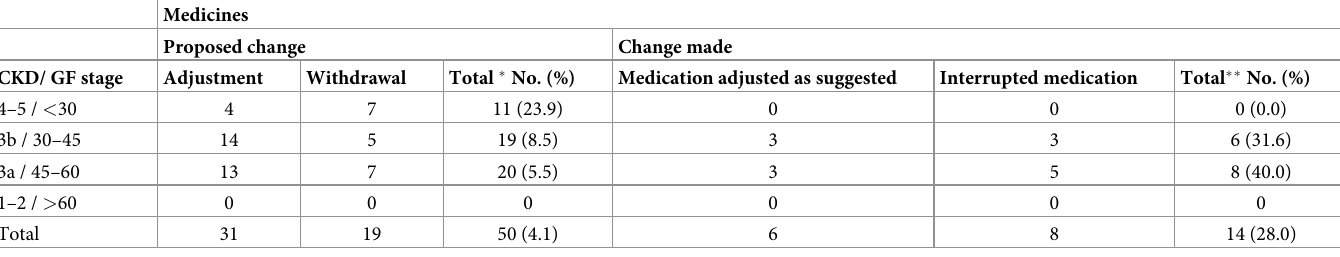
Table 5. Proposed changes and results